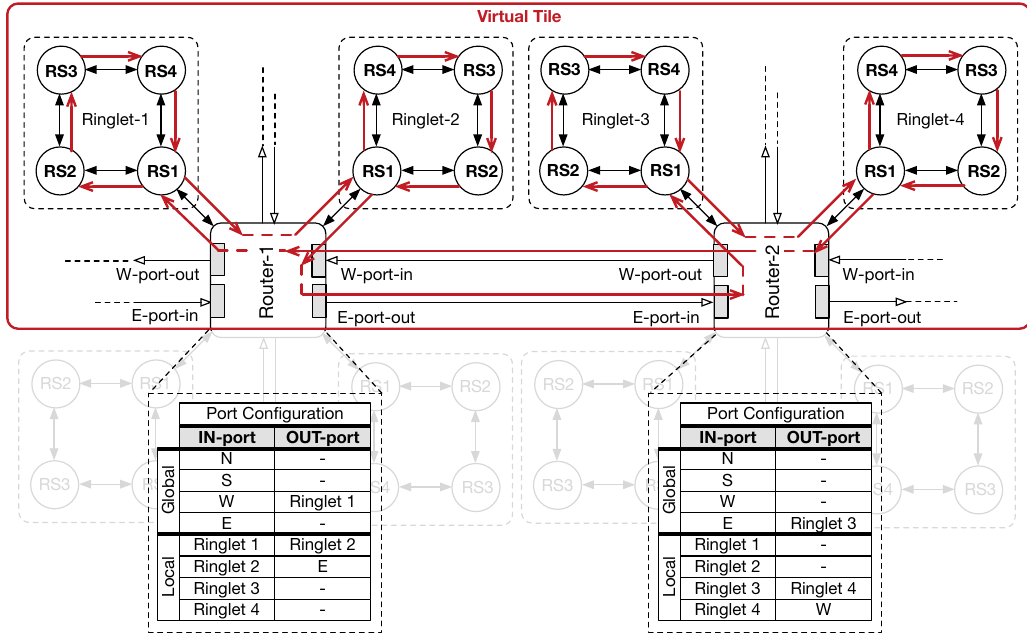
Figure 6. Coarse-grain reconfigurable architecture (CGRA) reconfiguration: two physical tiles (PTs) are reconfigured to create a single virtual tile (VT) using half of the ringlets in each PT—in red, the virtual topology